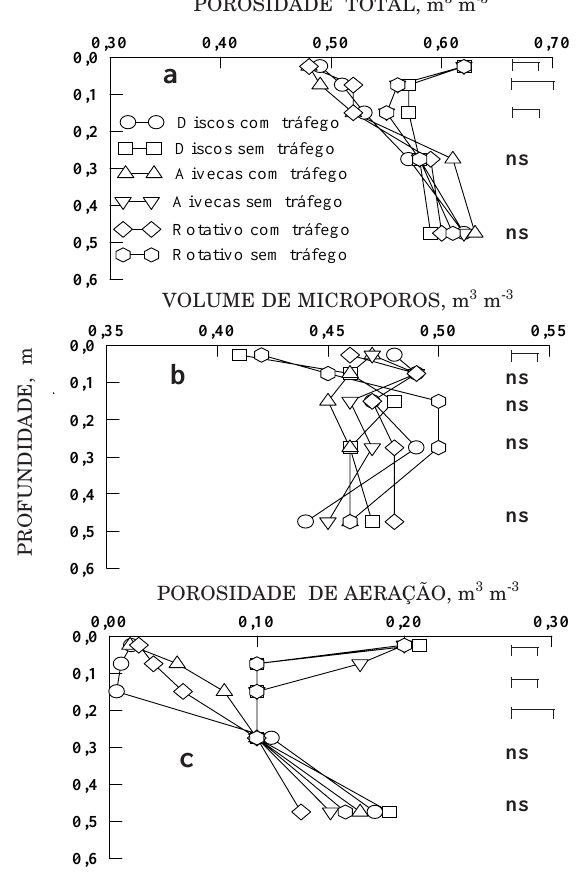
Figura 3. Porosidade total (a), volume de microporos (b) e porosidade de aeração (c) do solo obtidos na amostragem realizada em maio de 1991. (As barras horizontais indicam as diferenças mínimas significativas entre os tratamentos obtidas pelo teste de Tukey (p < 0,01) e ns indica ausência de diferenças entre os